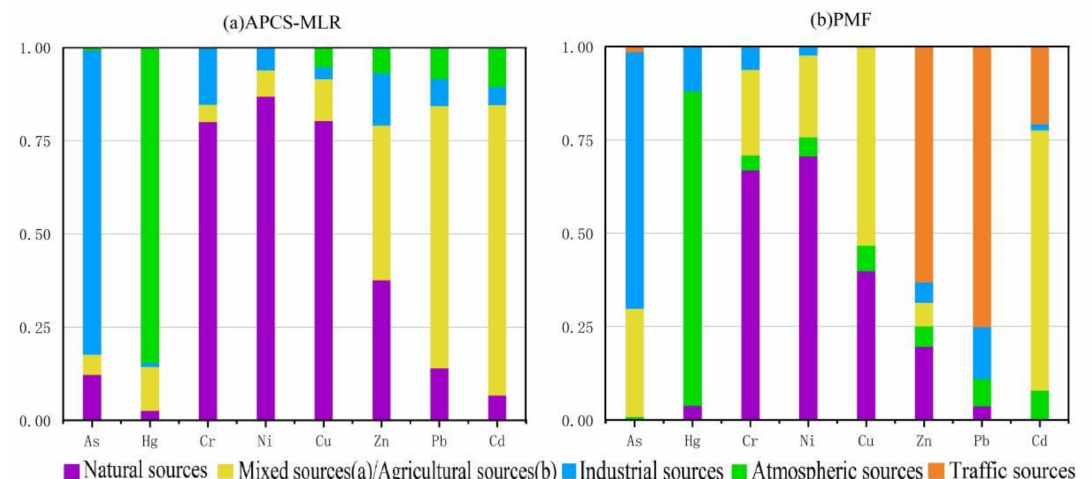
Figure 4. Source contributions to heavy metals derived from APCS-MLR ( a ) and PMF ( b ). APCS- MLR, absolute principal component scores-multiple linear regression; PMF, positive matrix